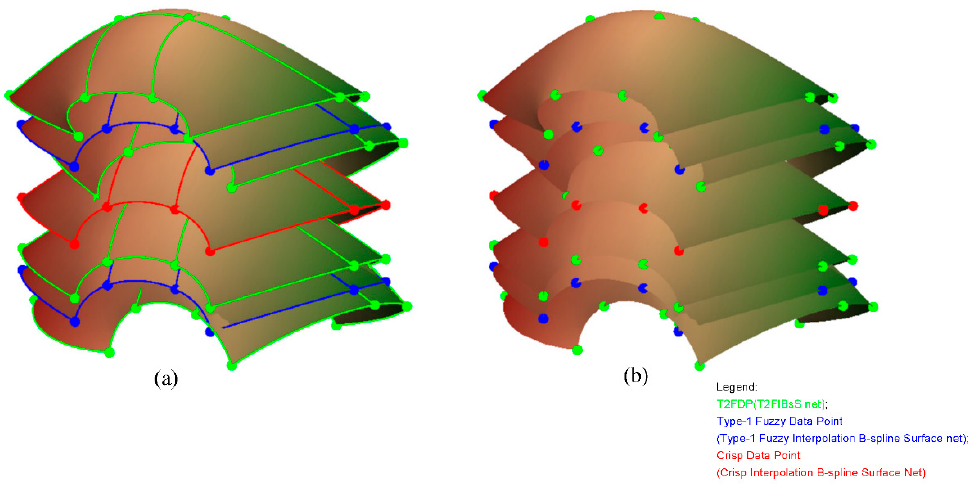
Figure 7. The example T2FIBsS model: with ( a ) and; without ( b ) type-2 fuzzy data net.